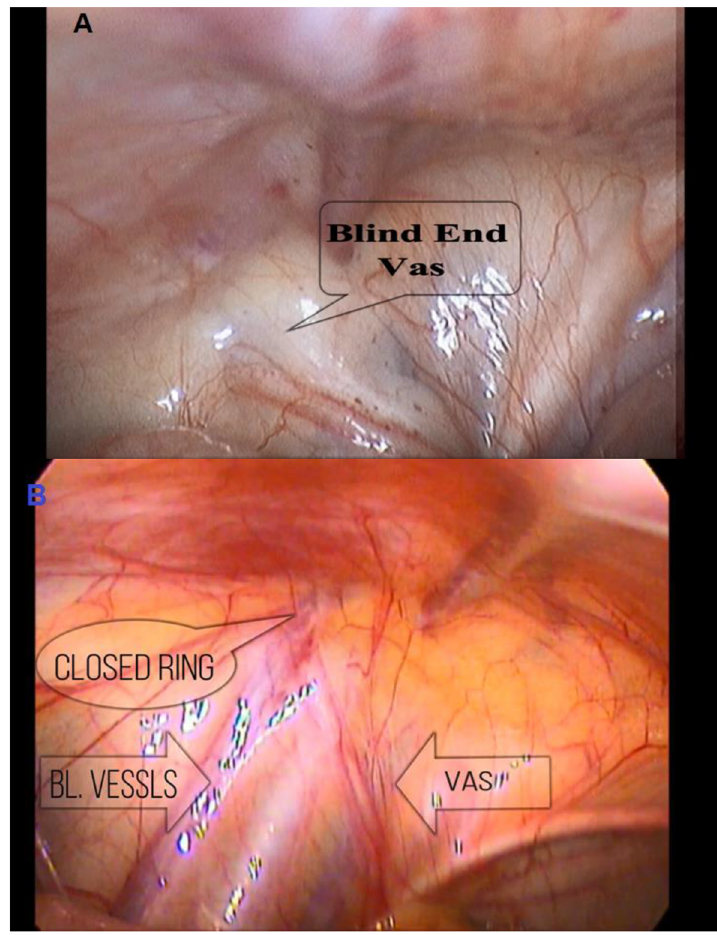
Fig. 11 a , b Vanished proximal portion of the left vas